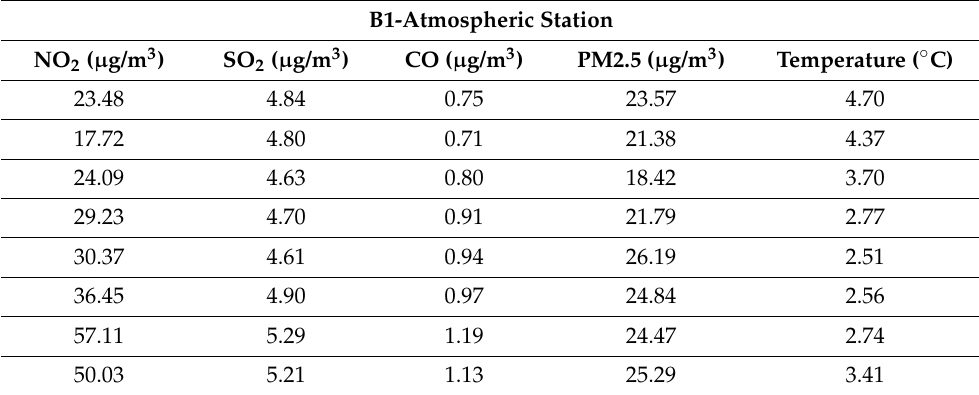
Table 2. Examples of input data used in machine